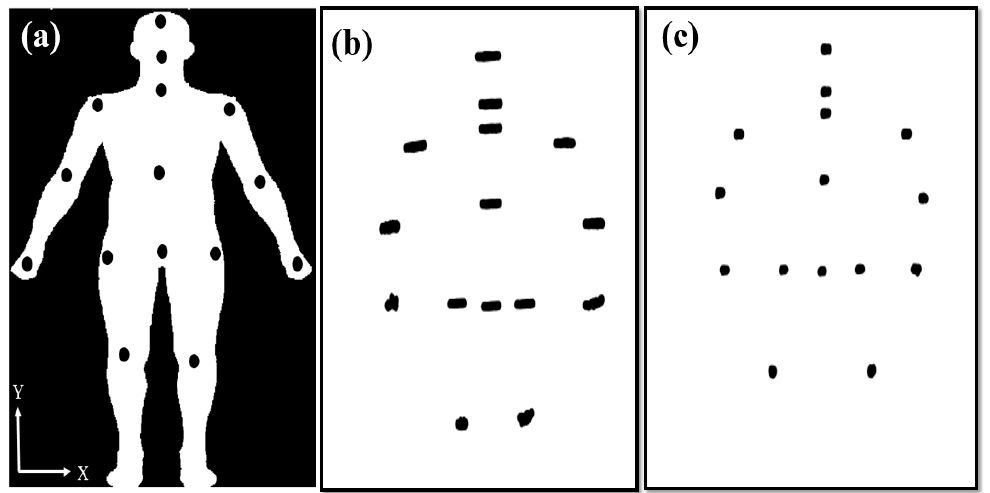
Figure 3. ( a ) The Kinect device recorded the positions of 15 joints; joint–node plots of ( b ) an elderly adults and ( c ) a young adult over a period of 40 s.